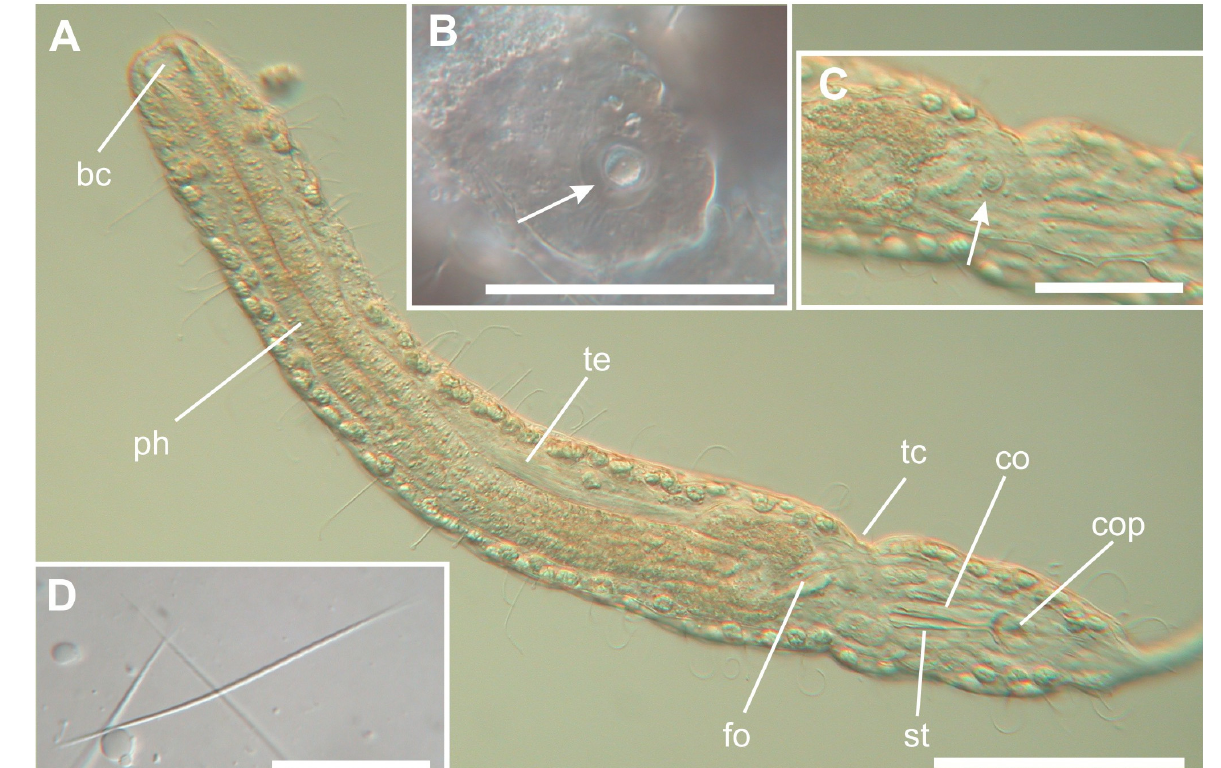
Figure 3. Photomicrographs of Urodasys bifidostylis sp. nov. (Nomarski optics). ( A ) Habitus of an adult specimen, with detail of the internal anatomy as seen from the ventral side. Inserts ( B , C ) details from the dorsal side showing the external pore of the frontal organ. Insert ( D ) testicular spermatozoa.